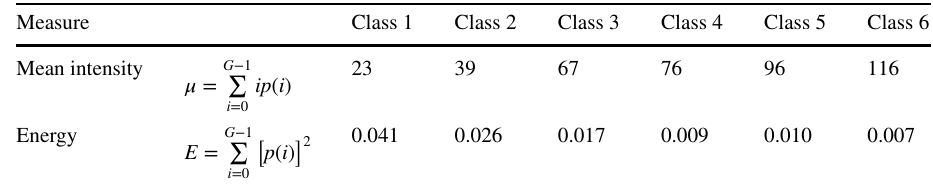
Table 4 First order statistics for